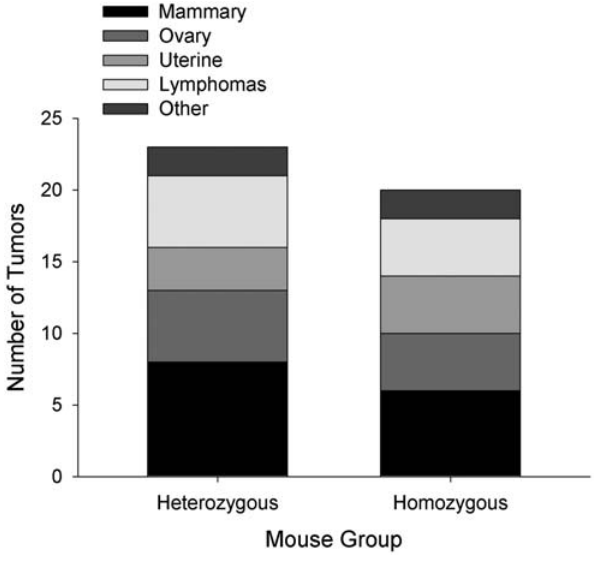
Figure 2. Tumor types induced in the HTZ and HMZ mice.